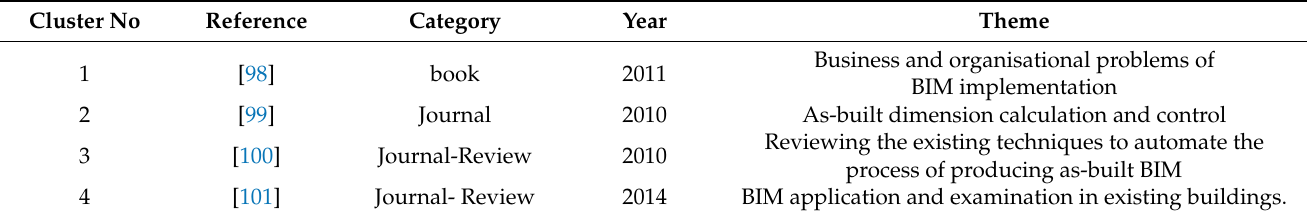
Table 3. Co-citation analysis.